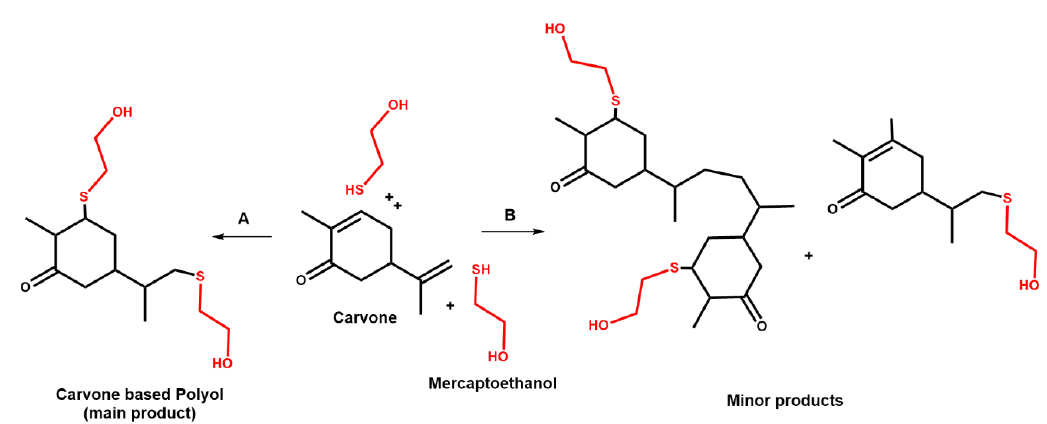
Figure 3. The chemical reaction for the synthesis of carvone-based polyol ( A ) along with expected byproducts ( B ).